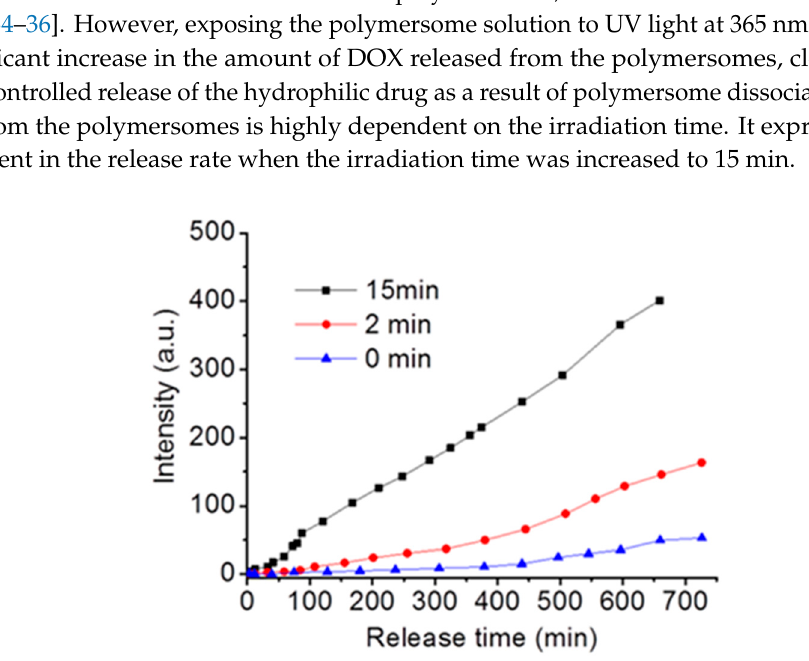
Figure 5. The Polymersomes as carriers for light-controlled release of hydrophobic drugs, NR: ( a ) Emission spectra of NR for the polymersomes solution without UV irradiation; ( b ) Emission spectra of NR for the polymersomes solution under UV irradiation at 365 nm.